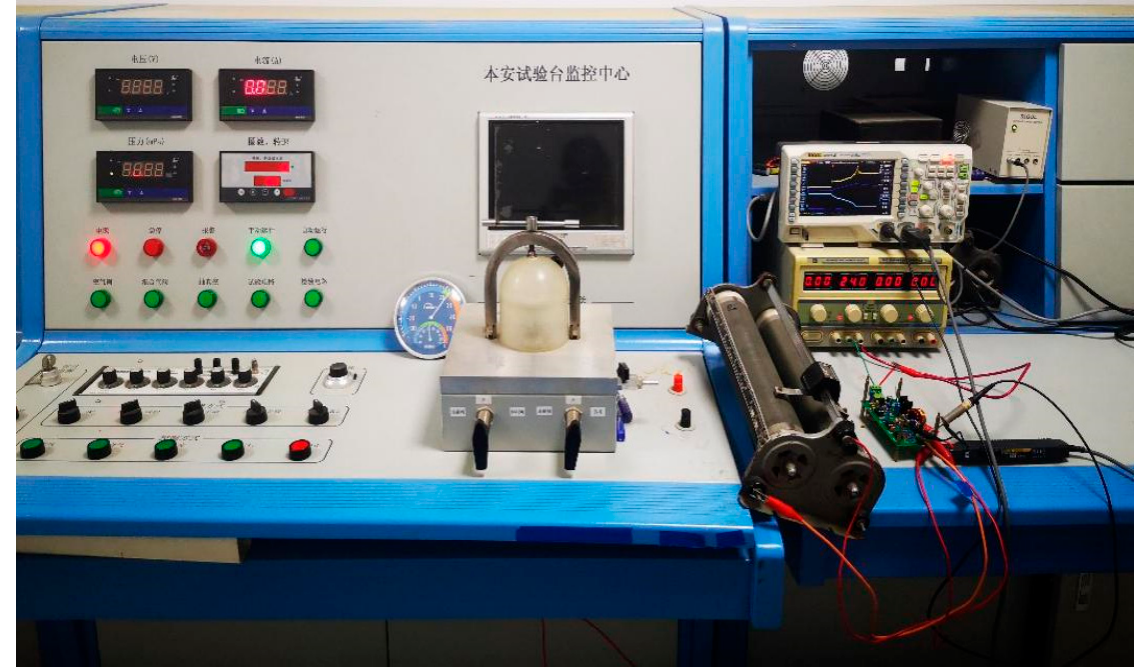
Figure 8. Intrinsically safe spark test device.